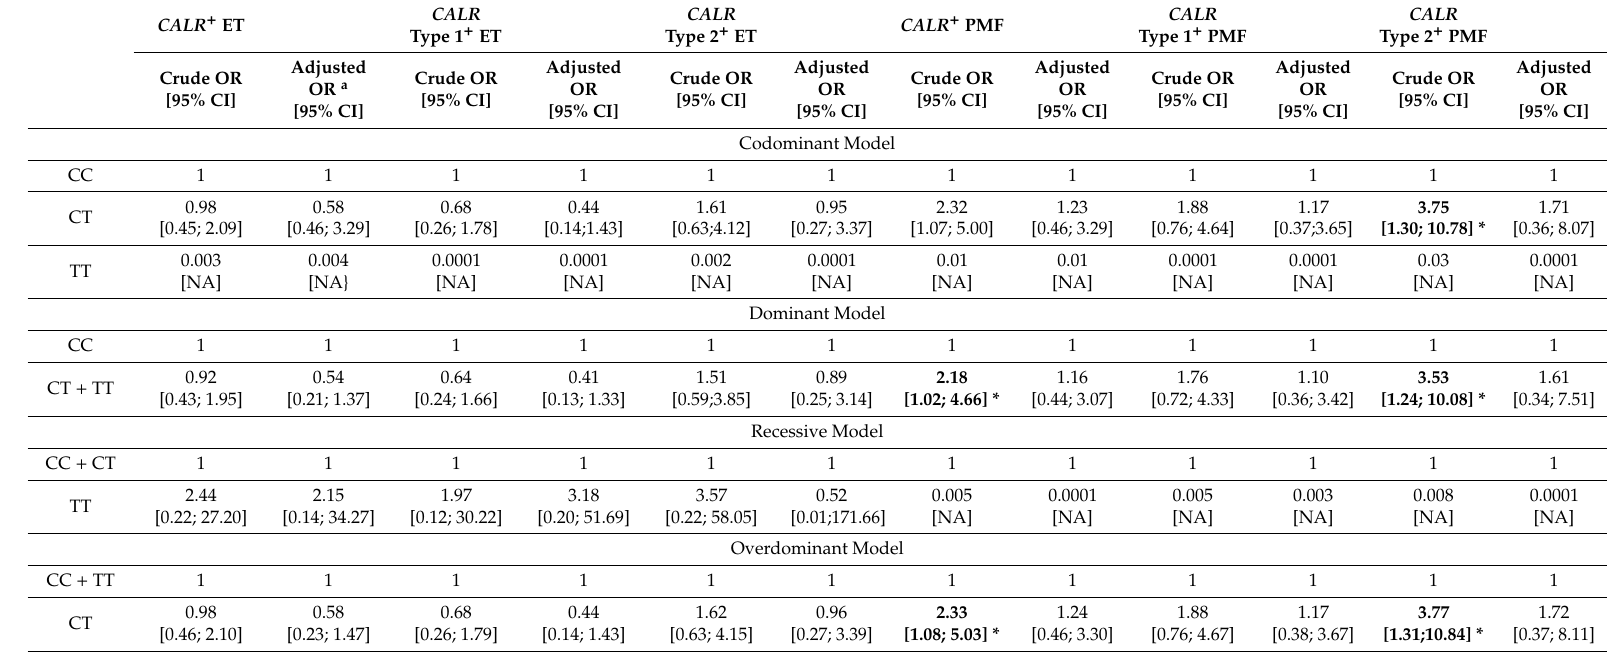
Table 5. Associations between TET2 rs154843 SNP and CALR -positive MPN molecular subtypes: multinomial logistic regression